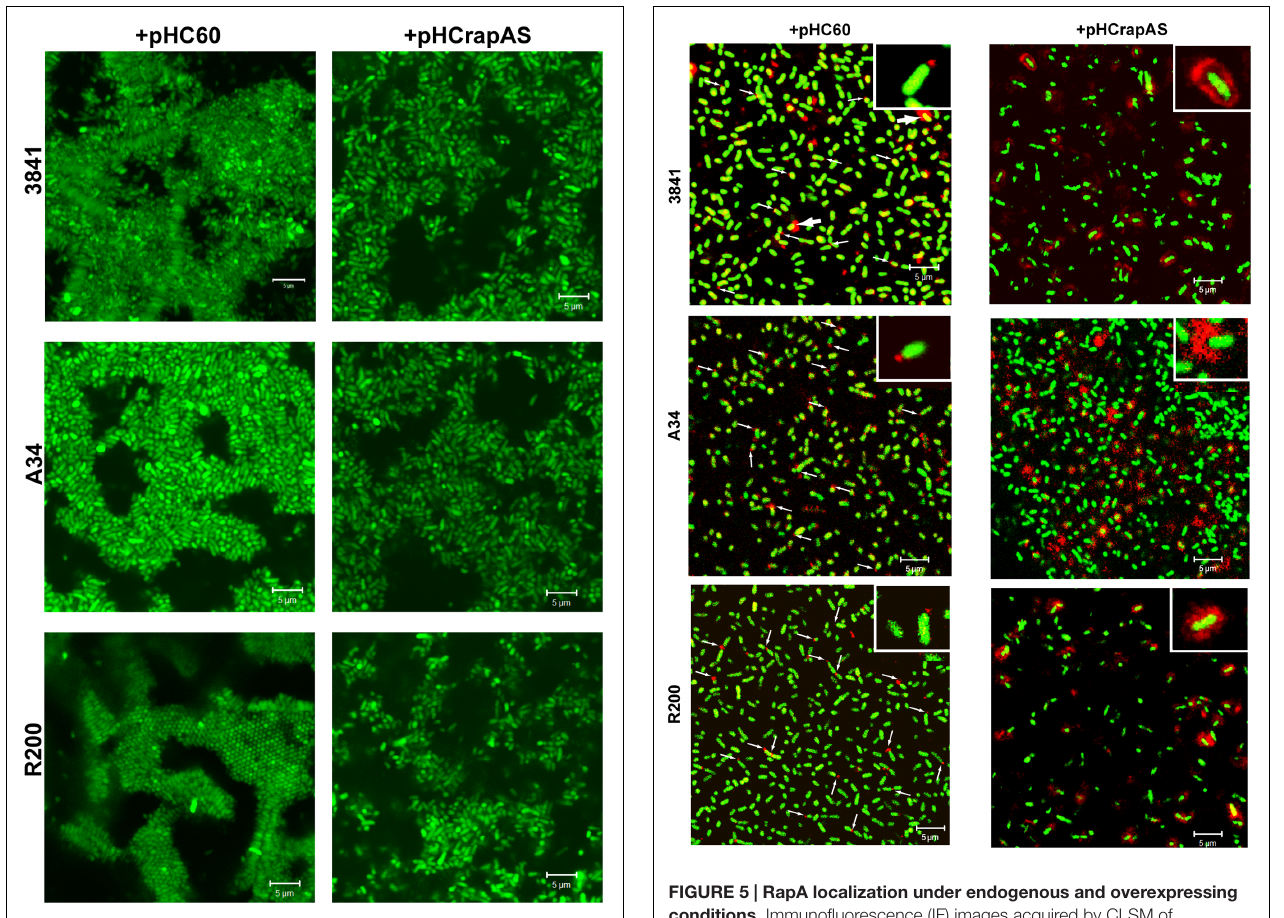
FIGURE 4 | RapA1 overproduction expands distances between bacterial cells. CLSM images of 3841, A34, and R200 strains harboring pHC60 or pHCrapAS grown in chambered cover slides for 4 days in Y-minimal medium. Representative CSLM images of at least three different experiments observed using a Plan-Apochromat 100x/1.4 Oil Objective from a Carl Zeiss PASCAL LSM 5 are shown. White bar: 5 µ m.